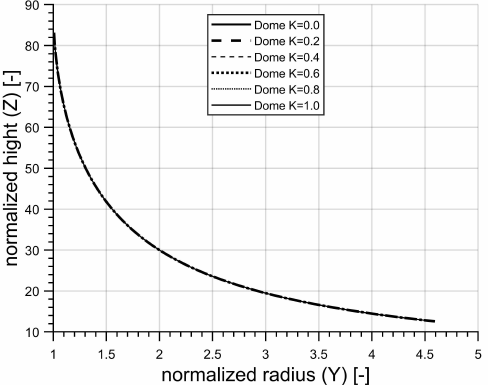
Figure 4. Winding angles for each